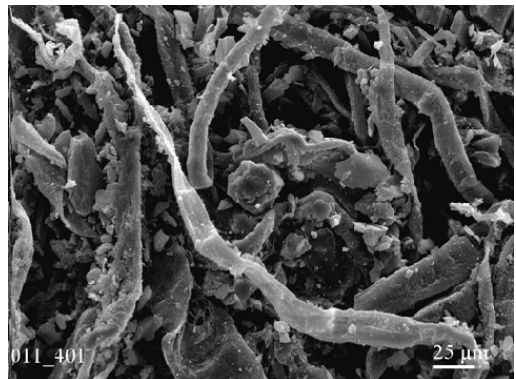
Figure 3. SEM image of a cellulose-carbon membrane.